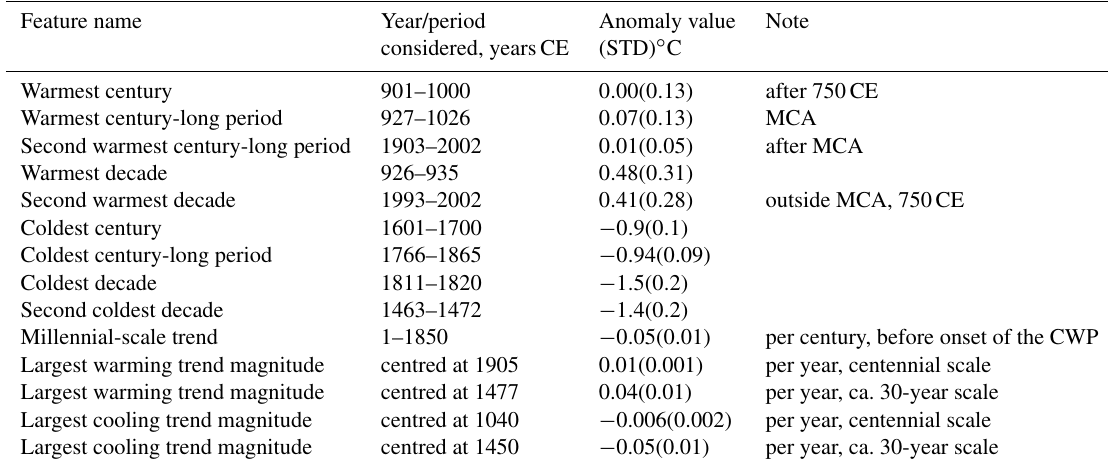
Table D4. Summary of some of the major features of the new Arctic2K reconstruction ensemble. Anomalies are given relative to the period of